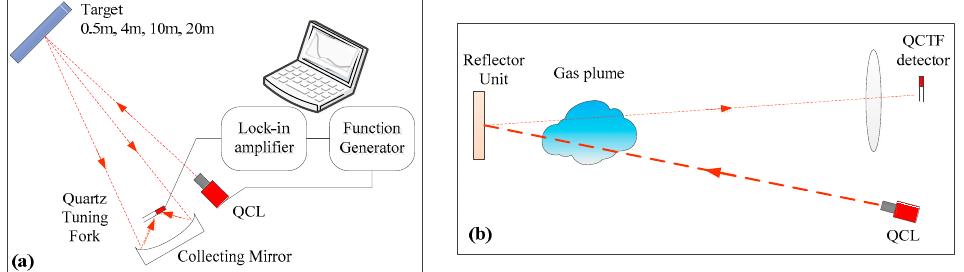
Figure 7. Diagram of the experimental setup variation of QEPAS for standoff detection of ( a ) surface adsorbed chemicals [161,162]; ( b ) gas plume [163,164].